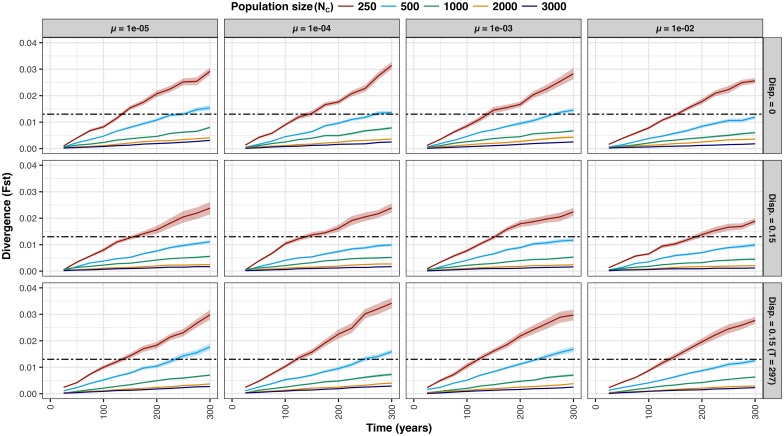
Results of the first 300 years of population divergence simulations (scenarios 1, 2, and 3) conducted in RMETASIM.FST versus time (years) is plotted based on the 25 year increment mean values derived from 32 simulation replicates conducted for each population size (as shown in the legend), microsatellite mutation rate, and dispersal combination. Shading represents 95% confidence intervals. Horizontal hatched lines reflect the level of FST observed empirically between upstream and downstream populations after fast-growing outliers were removed from the downstream juvenile group.